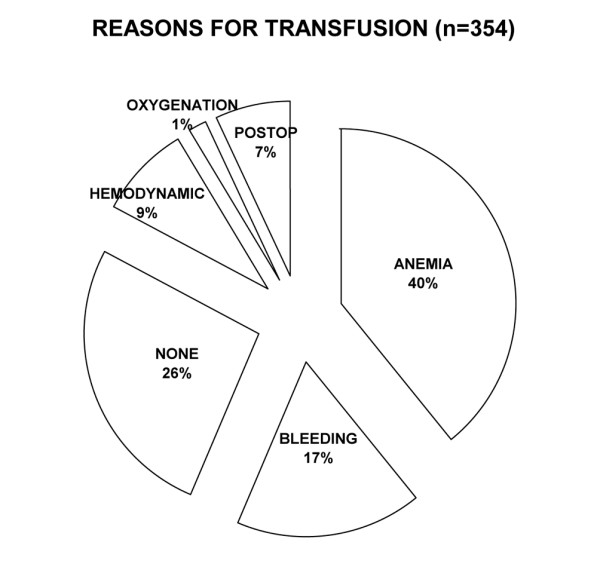
Reasons for transfusions.